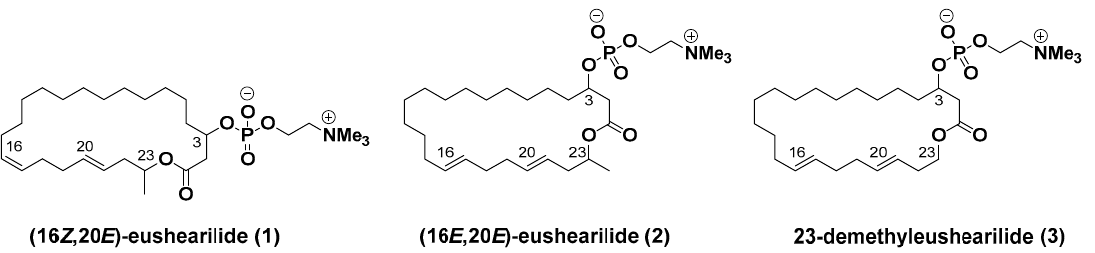
Figure 1. Structures of eushearilide congeners and the 23-demethyl derivative.